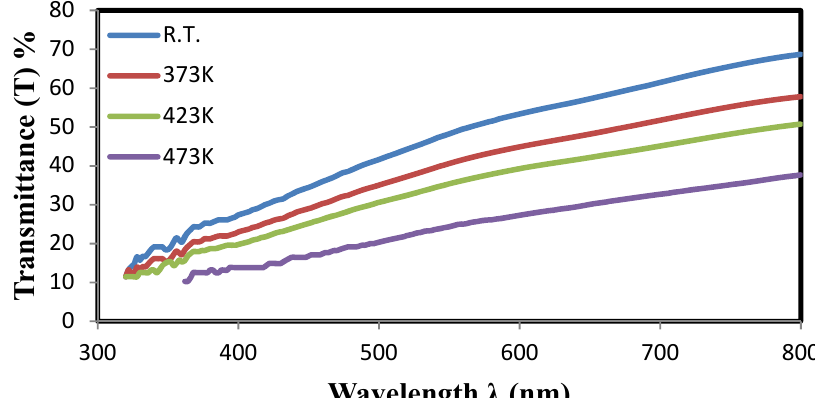
Fig. 2: The variation of transmittance spectra with wavelength for NiO